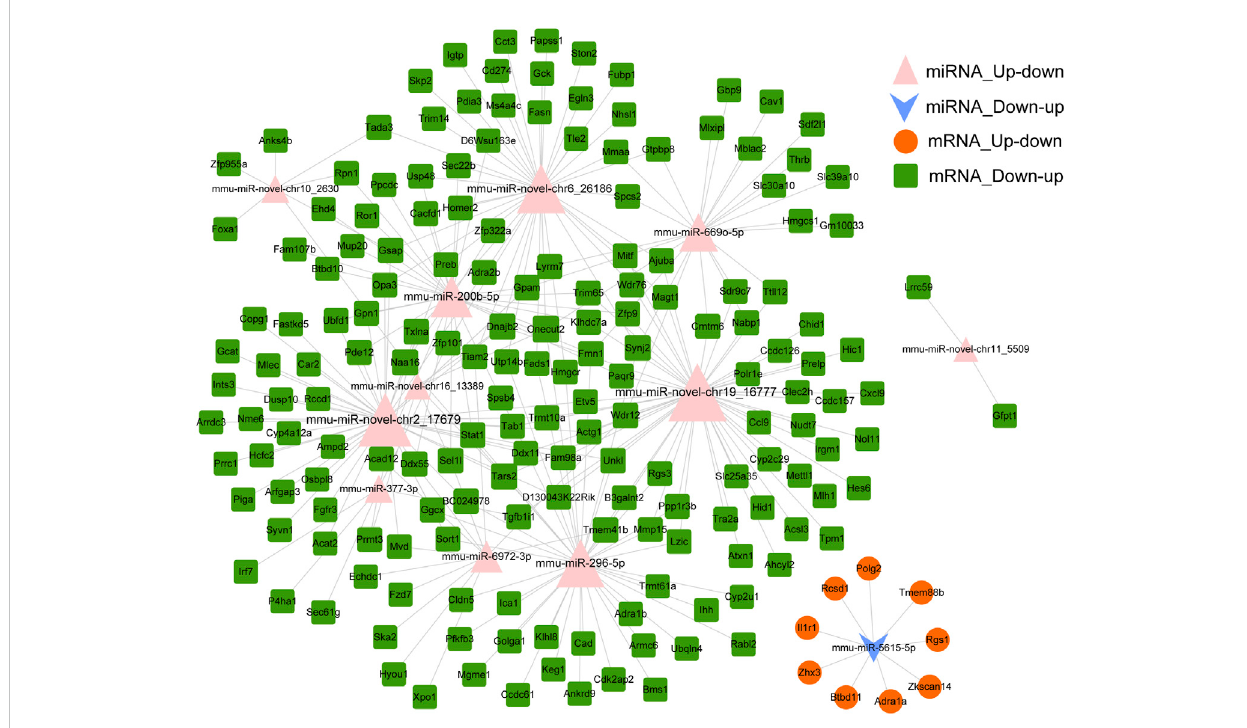
FIGURE 7 miRNA – mRNA regulatory network. The miRNA – mRNA regulatory network was constructed with 275 miRNA – mRNA pairs in which the regulatory trend between miRNAs and mRNAs was in contrast. The pink triangle indicates miRNAs upregulated and subsequently downregulated in the Fed – Fast – Refed cycle. The blue inverted arrow indicates miRNAs downregulated and subsequently upregulated in the Fed – Fast – Refed cycle. The orange circle indicates mRNAs upregulated and subsequently downregulated in the Fed – Fast – Refed cycle. The green square indicates mRNAs downregulated and subsequently upregulated in the Fed – Fast – Refed cycle. The node size shows the degree of connection. The grey line shows regulatory interaction between miRNA and targeted